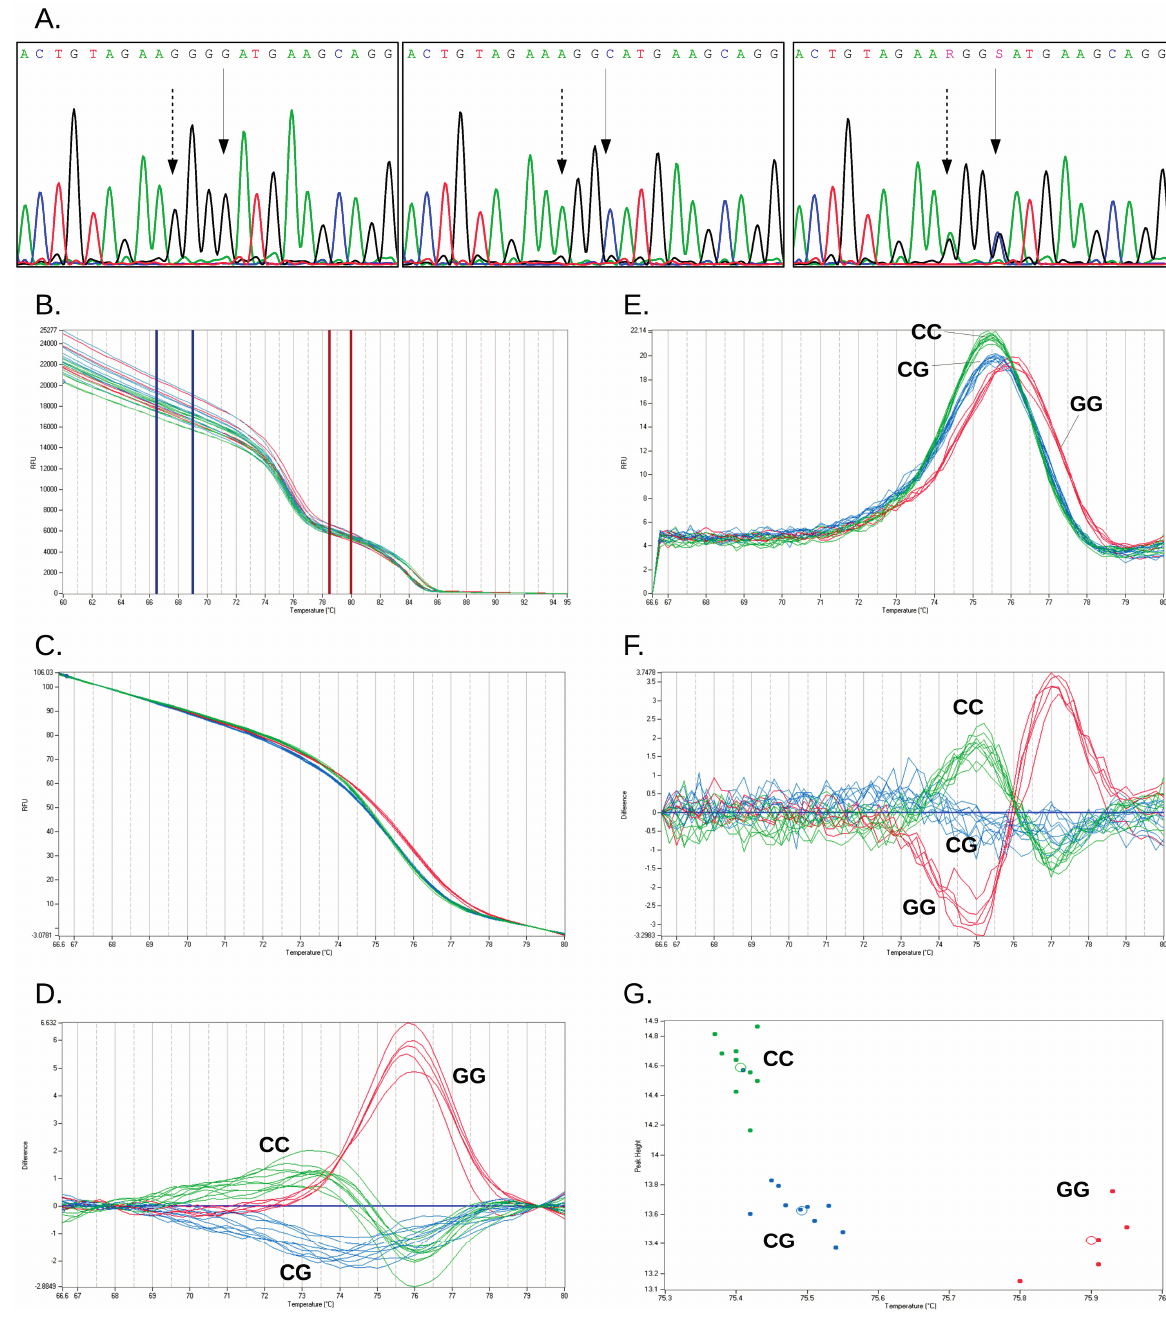
Figure 1. Genotyping of PNPLA3 rs738409 SNP by sequencing and high-resolution melting curve analysis. ( A ) Representative Sanger sequencing traces for the three genotypes of rs738409 (from left to right: CC, GG, and CG; note that Sanger sequencing was performed in genome orientation, which is opposite to the rs); continuous arrows show rs738409 position; dashed arrows: rs738408 position; ( B – G ) Representative curves for high resolution melting of rs738409 amplicons: ( B ) non-normalized melting curves and placement of normalization intervals; ( C ) normalized melting curves; ( D ) RFU difference clustering; ( E ) negative first derivative of the normalized melting curves; ( F ) dF/dT difference clustering; and ( G ) scatter-plot. PNPLA3 genotypes: red, GG; green, CC, blue,